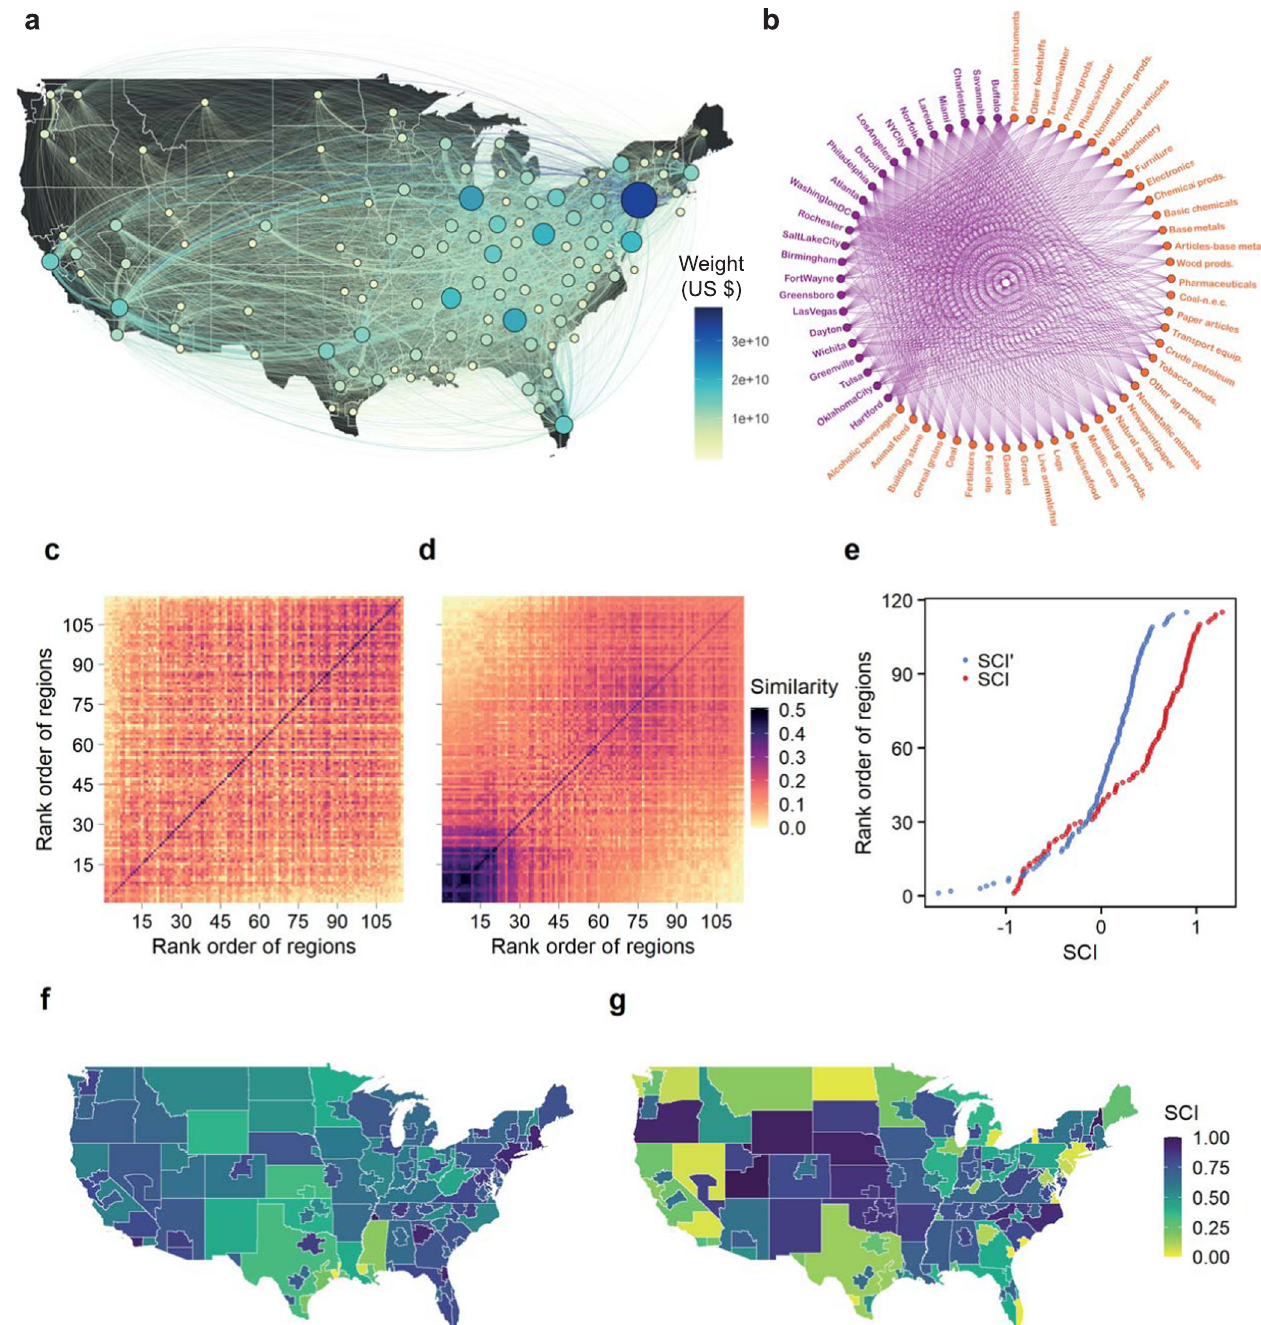
Fig. 1 Work fl ow created to calculate supply chain complexity indices. a Illustration of the supply network for pharmaceutical products in the United States in 2012. Although not shown for clarity, the network includes international connections to the rest of the world via eight different world regions. The nodes in the network correspond to the 115 United States regions in our dataset. The node size represents the total supply in fl ows to a node (in-strength), and links represent the supply fl ows (in dollar units) between nodes, with the direction of fl ow being clockwise. b Binary bipartite network of product-region pairs (only the 25 most populous cities are shown) derived from all spatial supply networks in 2012. Similarity matrix for SCI ( c ) and SCI ′ ( d ) derived from the product-region bipartite network. e Rank order of cities and regions with respect to their unstandardized SCI and SCI ′ values. Mapping of normalized SCI ( f ) and SCI ′ ( g ) values for cities and regions in the United national share (Methods). The product – region pairs with LQ ≥ 1